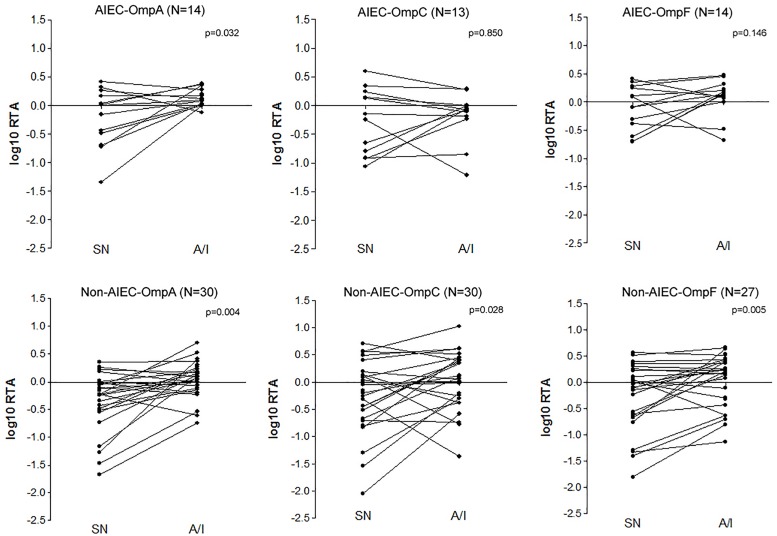
Paired tests evaluating the OMPs expression difference between supernatant and cell-associated fractions of infected I-407 cultures in each strain collection (AIEC and non-AIEC). Values indicate the logarithmic ratio of relative transcript abundance (RTA) of the target sample, being RTA = Efficiency ^(Ct target gene reference strain – Ct target gene sample)/Efficiency ^(Ct constitutive gene reference strain – Ct constitutive gene sample) (Pfaffl, 2001).